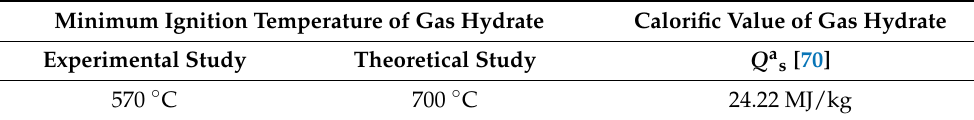
Table 1. Minimum temperatures required for the gas hydrate ignition and calorific value.